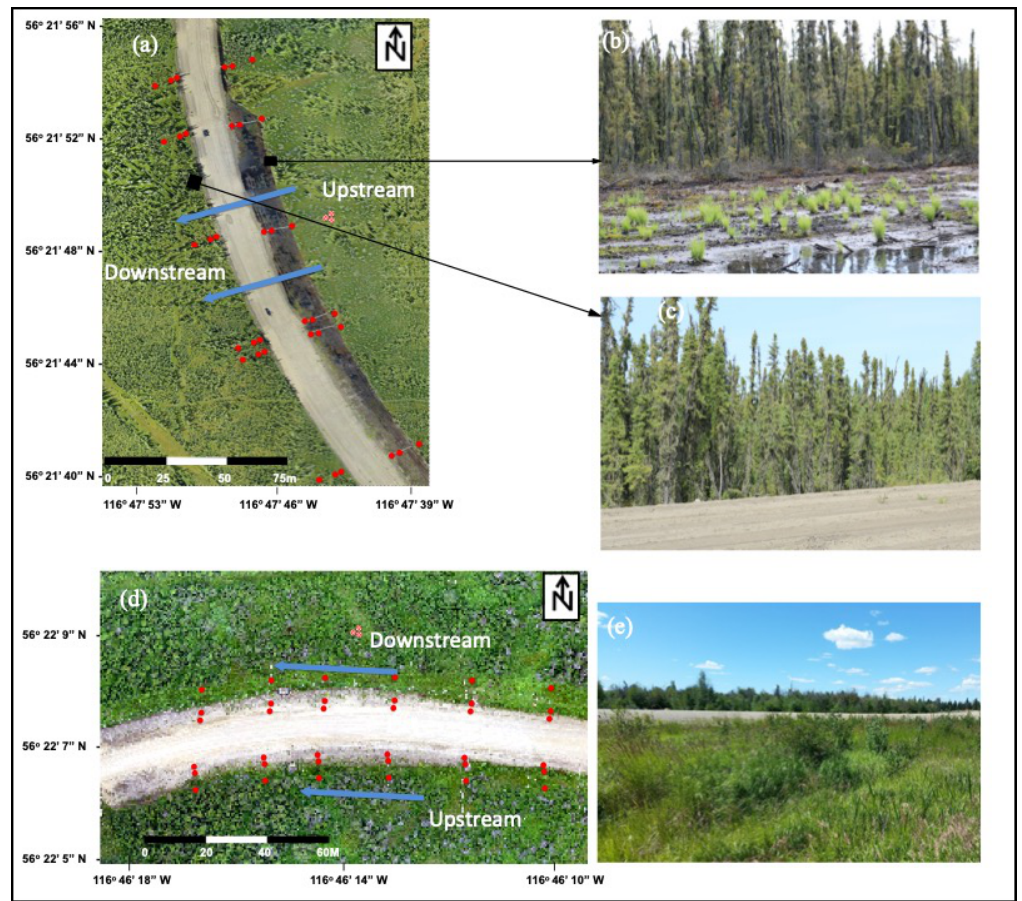
Figure 1. ( a ) Bog site aerial view taken in 2016, ( b ) bog upstream side of the road close up view, ( c ) bog downstream side of the road close up view, ( d ) fen site aerial view taken in 2015 and ( e ) fen site looking into upstream from the downstream site. Red circles represent the location of sample plots along the transects, circles with pattern fill are reference site plots, and arrowheads inside maps show flow direction after road